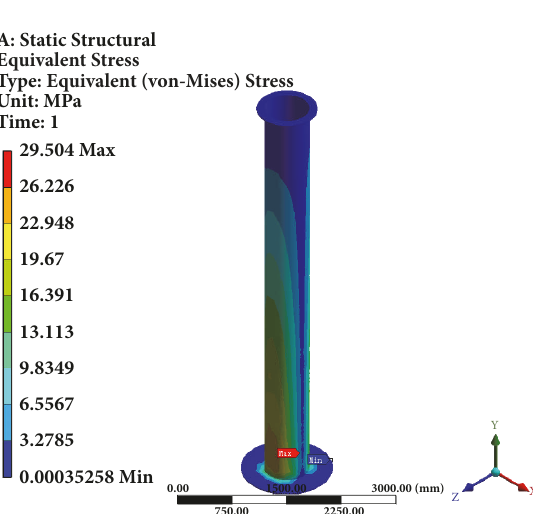
Figure 13: Equivalent stress contour of